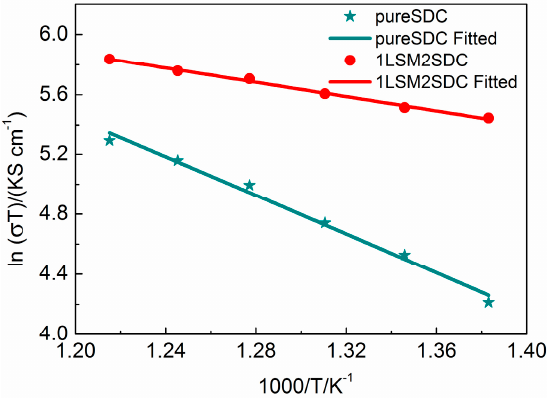
Figure 6. Arrhenius plots of ionic conductivity of LSM-SDC (La 0.1 Sr 0.9 MnO 3 −δ -Ce 0.8 Sm 0.2 O 2 −δ ) composite (1:2, weight ratio) and pure SDC material.